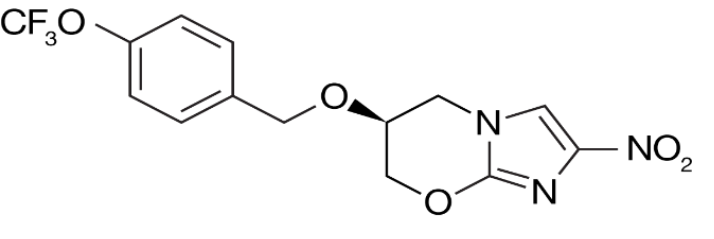
Figure 7. Structure of pretomanid [91].